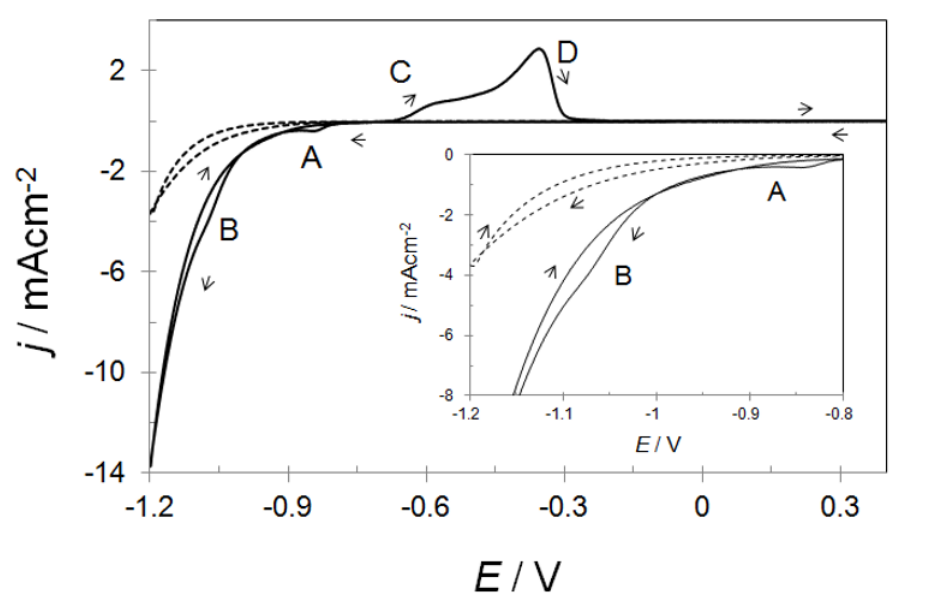
Figure 1. A typical cyclic voltammogram obtained in the system 0.01M CoSO started at 0.6 V towards the negative direction. Arrows indicate the potential scan direction. Cathodic density peak currents (A and B) and anodic peaks (C and D) are